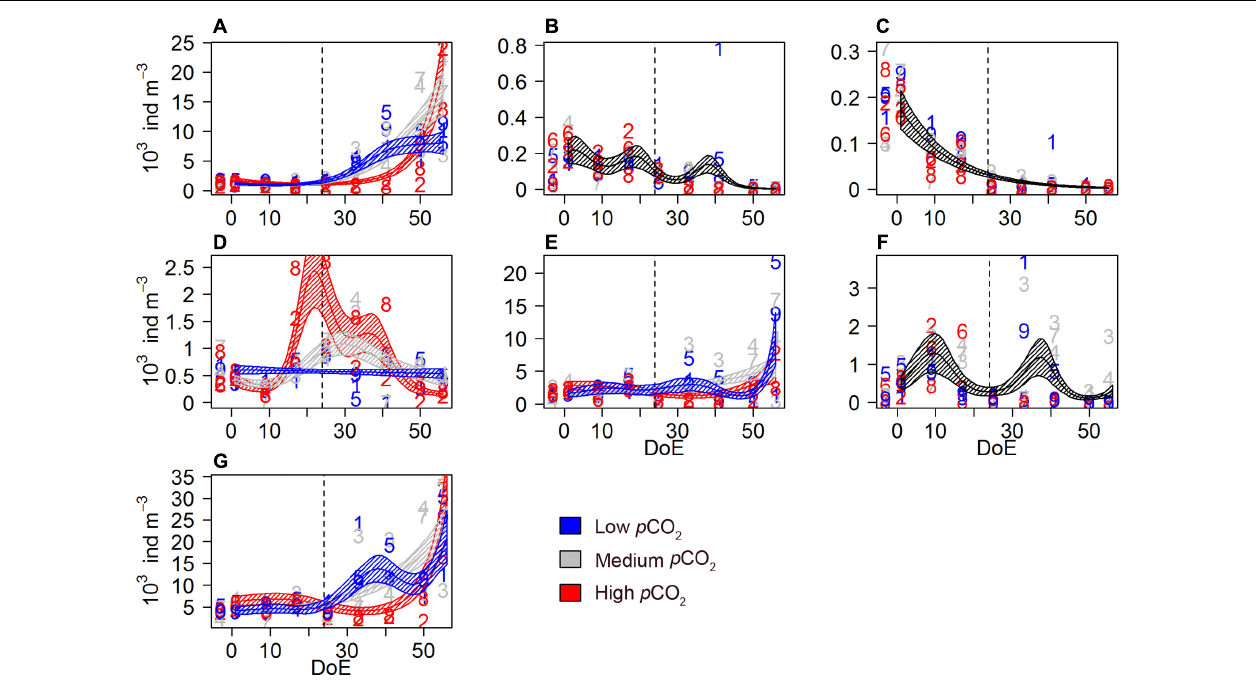
FIGURE 4 | Mesozooplankton abundances during the study period. (A) Calanoida, (B) Cyclopoida, (C) Harpacticoida, (D) Poecilostomatoida, (E) copepod nauplii, (F) O. dioica , (G) mesoZP total catch. Color code: blue = low- p CO 2 (M1, M5, and M9), gray = medium- p CO 2 (M3, M4, and M7), red = high- p CO 2 (M2, M6, and M8). Note that the black lines indicate that the model prediction for the three treatments is the same. DoE, day of experiment. For a better visibility of the data, y -axes have been adapted to abundances in each panel. Numbers represent abundances for the respective mesocosm (e.g., 9 for M9). Solid lines = prediction from Generalized Additive Mixed Models (GAMMs) (smoother trends p -value < 0.05); shaded area = confidence interval. Dashed line: t24, deep water